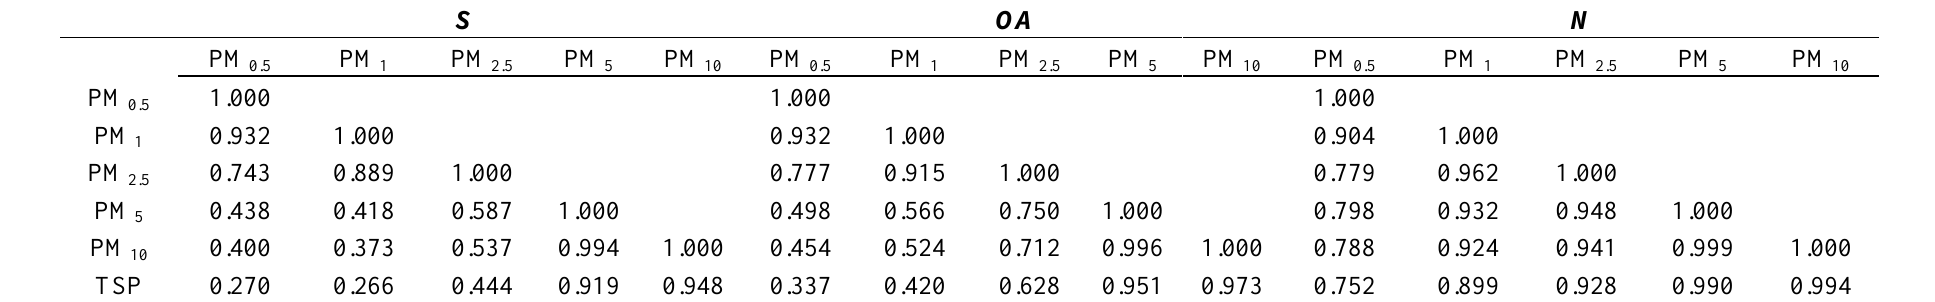
Table 5. Spearman correlation coefficients between the indoor PM fractions during S , OA and N